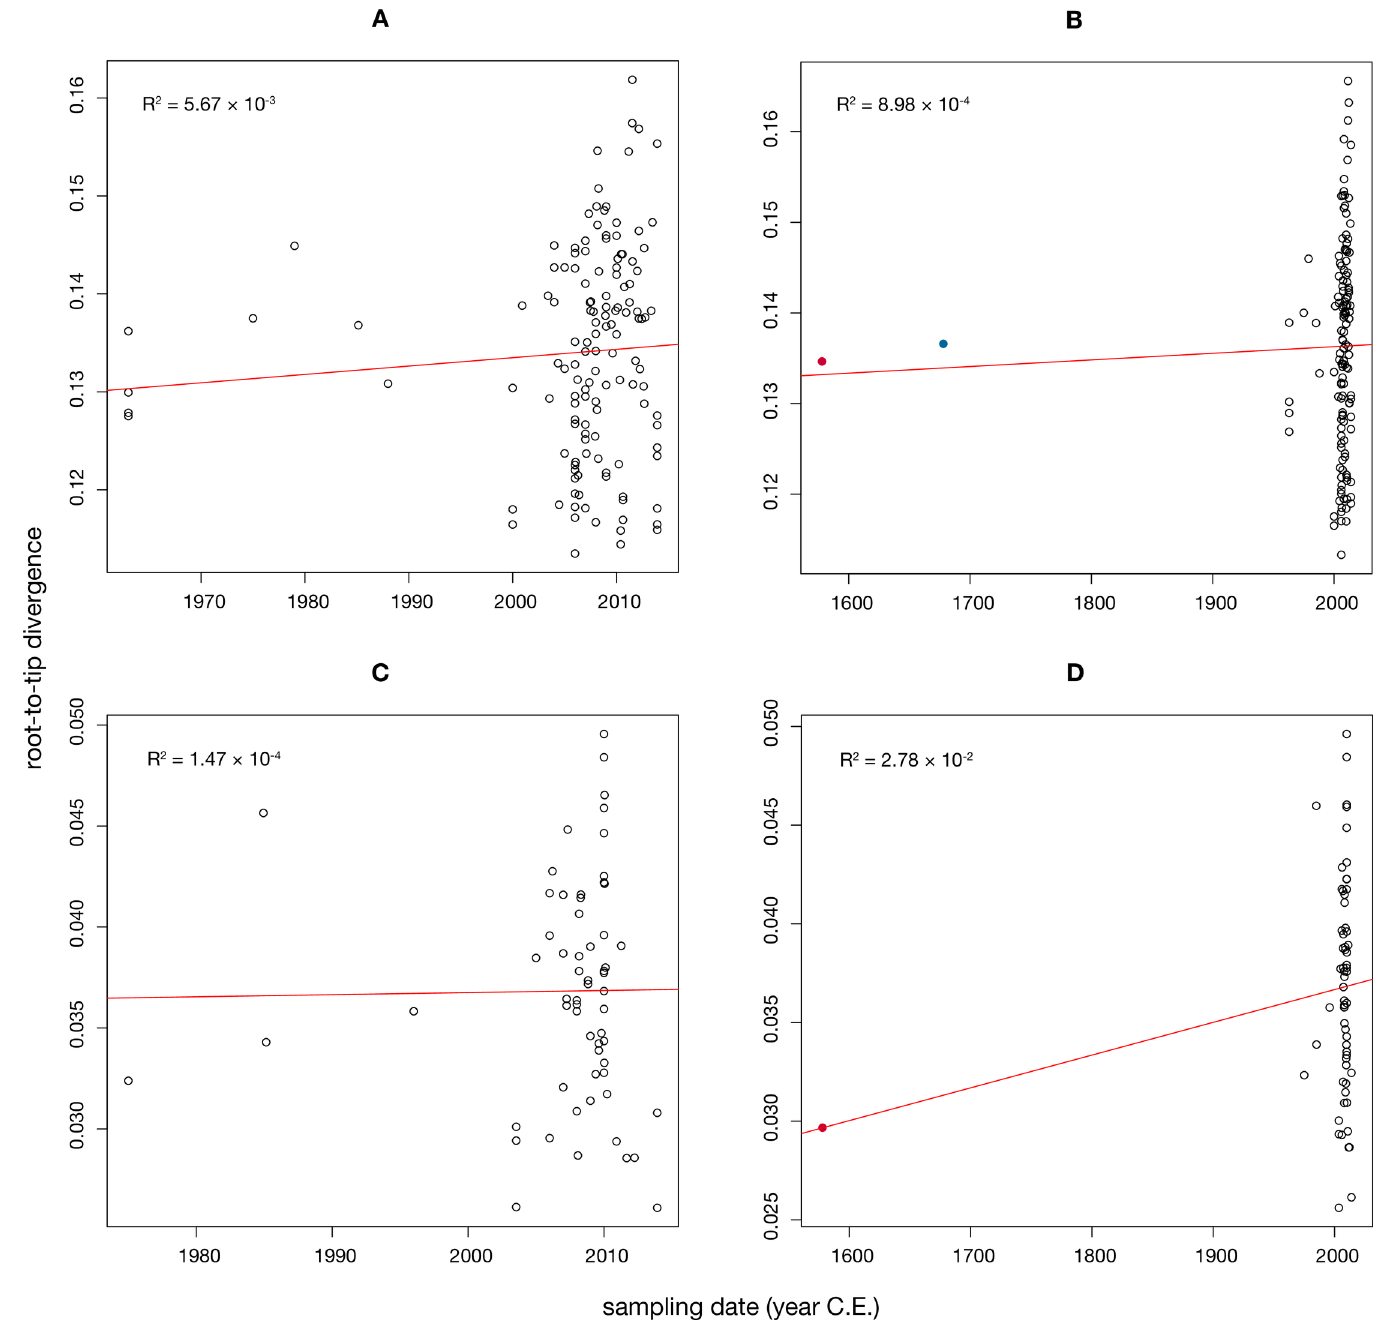
Fig 5. Root-to-tip regression analyses of temporal structure. Plots of the root-to-tip genetic distanceagainstsamplingtime (year) are shown for phylogenies estimated from alignmentsof random subsamples of wholeHBV diversity (subset a) or only D genotypediversity (subset b). Each dot represents a sequence,with black dots representingmodernsamples whilethat for NASD24SEQ is colored in red and that for JN315779 is colored in blue. R 2 values are given as an indicatorof the degreeto which evolutionhas been clock-like. The central line correspondsto the regressionline and the outer lines to the 95% confidenceintervals. Regressionanalysisfor other data sets are shown in S6 Fig. (A) Modern sequencesonly (subset a). (B) All modernand ancient HBV sequences(subset a-ii). (C) Modern genotypeD sequences(subset b). (D) Modern genotypeD sequenceswith NASD24SEQ (subset b-i).